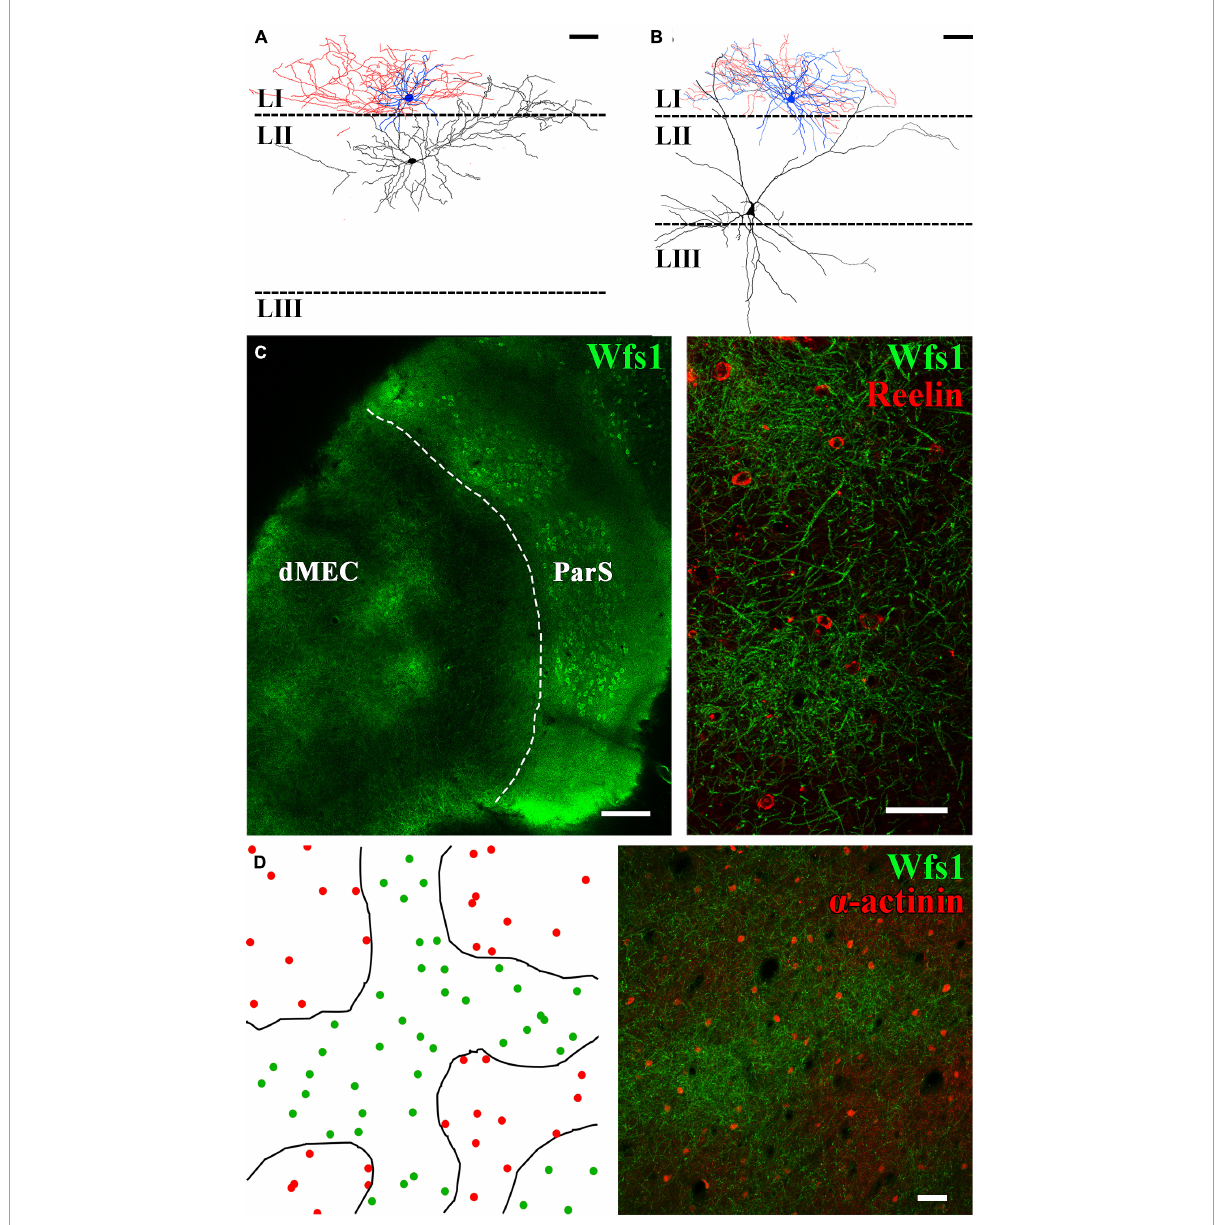
FIGURE4 The distribution of neurogliaform cells does not correlate with dendritic clustering of layer II pyramidal cells. Neurolucida partial reconstruction of two paired recordings. (A) Neurogliaform cell (soma and dendrites blue, axons red) together with layer II pyramidal cell (soma and dendrites, black). (B) Neurogliaform cell together with layer II stellate cell. Neurogliaform cell dendrites and axons are mostly restricted to layer I (scale bar: 50 µ m). (C) Tangential section of the mouse temporal cortex showing the dorsal MEC (dMEC) and the parasubiculum (ParS) (left, scale bar: 200 µ m). In layer I, dendrites of layer II pyramidal cells form patches, and Reelin-positive interneurons are located within and in between patches as well (right) (z-stack of 7 µ m section, scale bar: 50 µ m). (D) Left: drawings of the patch borders (black lines) and the positions of α -actinin+ putative neurogliaform cells (green dots within patches and red dots outside patch structures) in the rat MEC layer I. Right: representative low-magnification confocal image of the dorsal MEC layer I, based on which the drawing was made (z-stack of 30 µ m section, scale bar: 50 µ